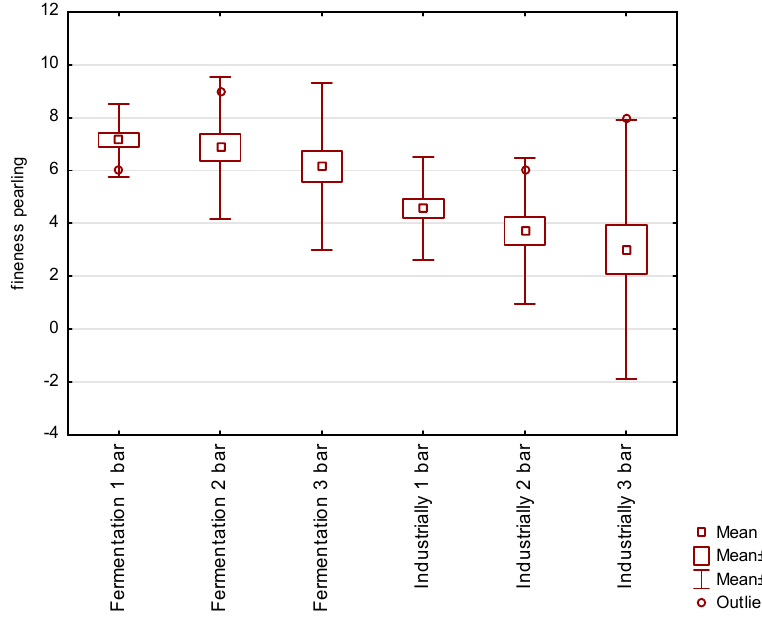
Figure 5. Pearling fineness of a carbonated water.